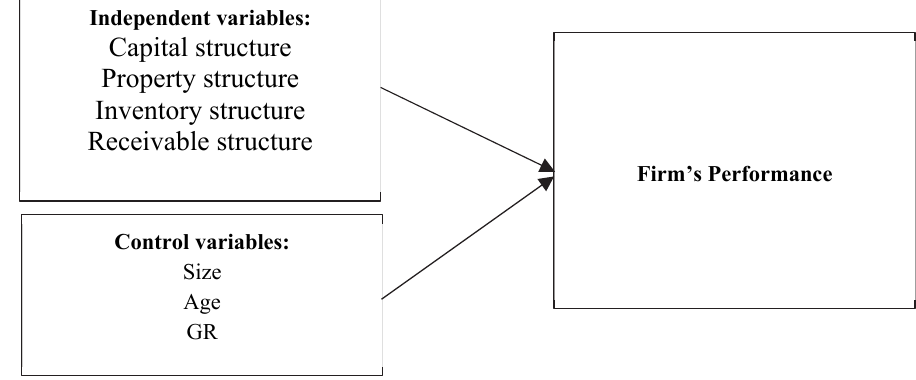
Fig. 1 . Research model of impact of financial structure on firm’s